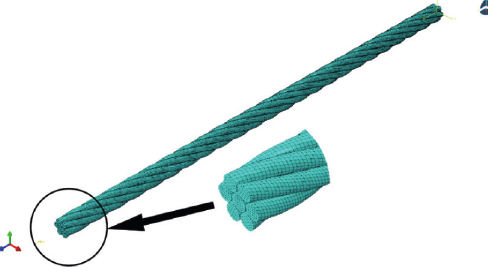
Figure 3: Finite element meshing